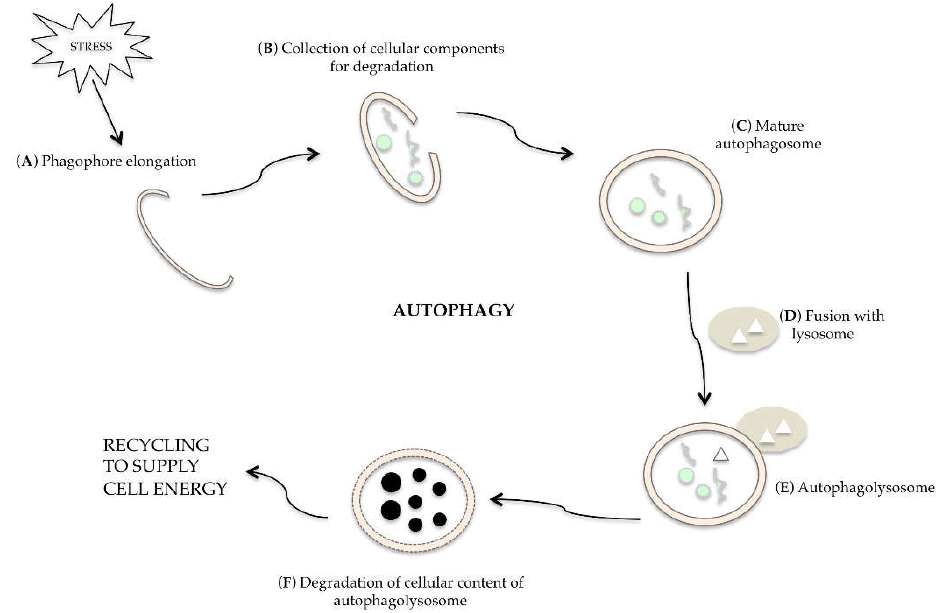
Figure 2. Description of cell autophagic phases: upon various stresses, a small double layer membrane, called phagophore, extends inside the cells ( A ) to collect cellular material to degrade ( B ) and to form autophagosome ( C ). After fusion with lysosome ( D ), the autophagolysosome is formed ( E ); thanks to the action of hydrolytic enzymes, cellular components are degraded ( F ) and recycled to supply cell energy. cell